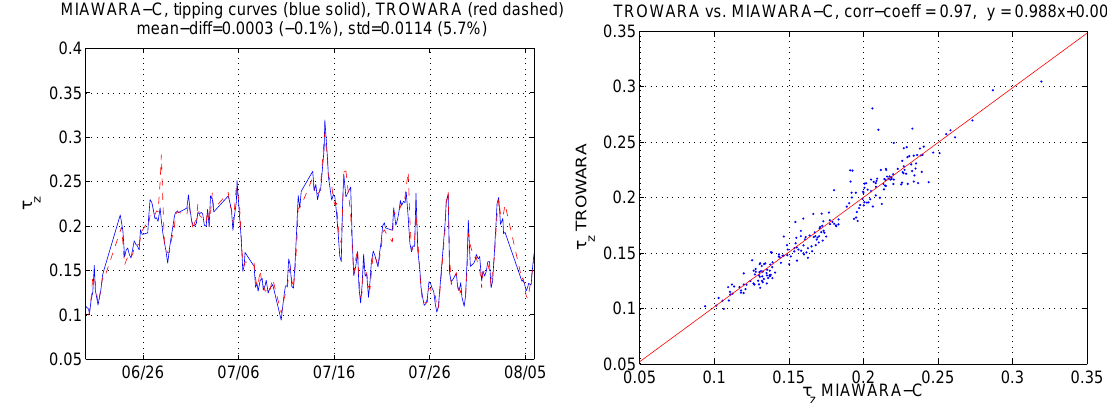
Fig. 7. Left panel: Time series of 4 hourly means of τ derived from MIAWARA-C tipping curves (mean value of 22 . 235 ± 0 . 1GHz) and TROWARA measurements at a constant elevation angle of 40 ◦ (mean value of 22 . 235 ± 0 . 2GHz). Right panel: Correlation between the data obtained in the time period from 20 June to 5 August